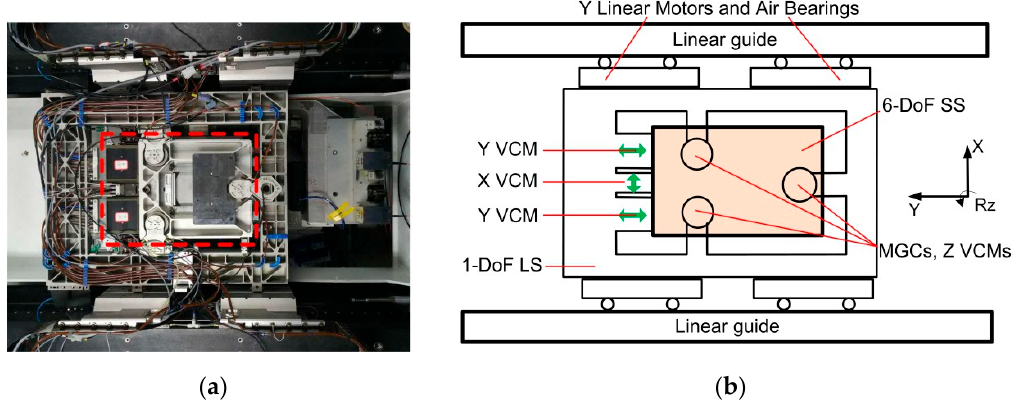
Figure 1. ( a ) Photograph and ( b ) schematic of the proposed non-contact Dual-Stage Actuator (DSA)